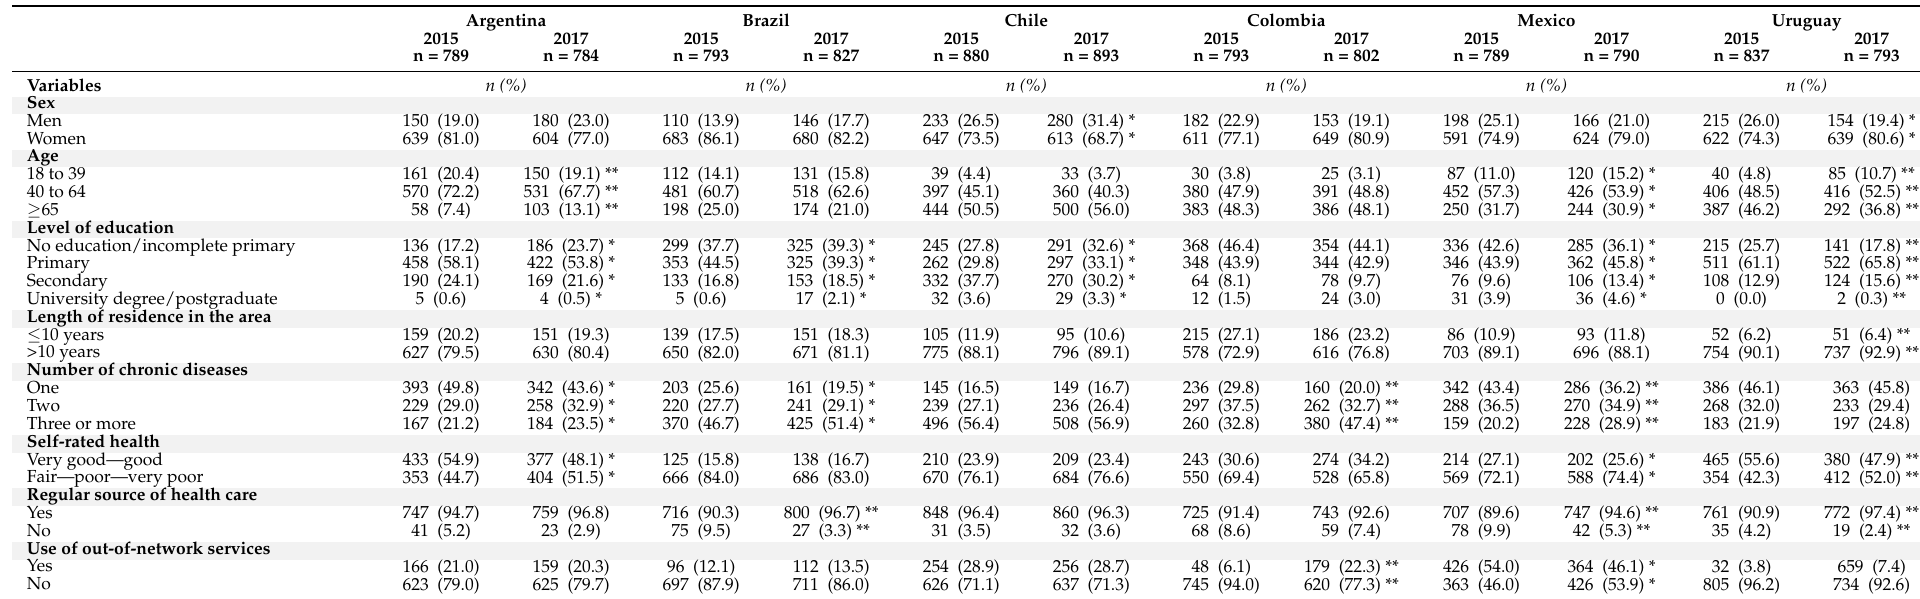
Table 1. Sociodemographic, morbidity, and health services utilisation characteristics of the sample, by country and year. CCAENA 2015–2017. Argentina Brazil Chile